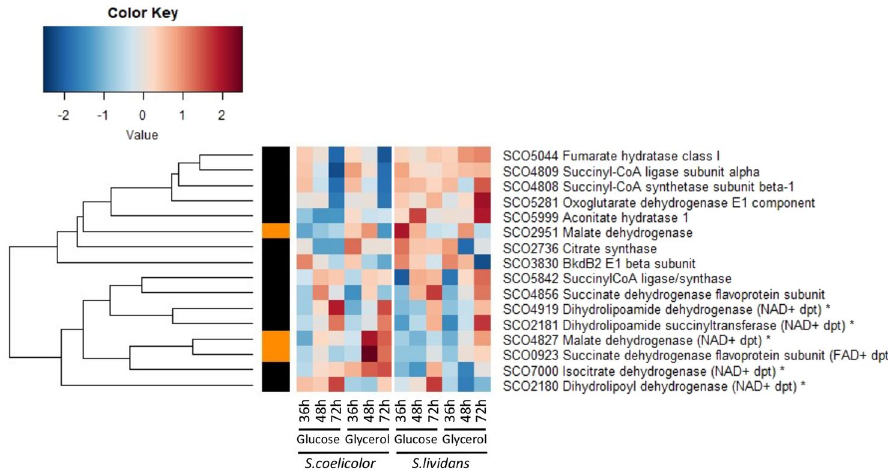
Figure 5. Heatmap representation of proteins belonging to the Tricarboxylic Acid Cycle with significant abundance change (ANOVA, adjusted p value < 0.05) between S. coelicolor (M145) and S. lividans (TK24) with either glucose or glycerol as main carbon source, for 36, 48 and 72 h. Protein identifiers are indicated as SCO numbers for both strains and by predicted functions. Enzymes with asterisks are catalyzing a reaction generating a reduced co-factor. The quantification methods are displayed in the vertical bar indicating proteins quantified by Spectral Counting (orange) or XIC